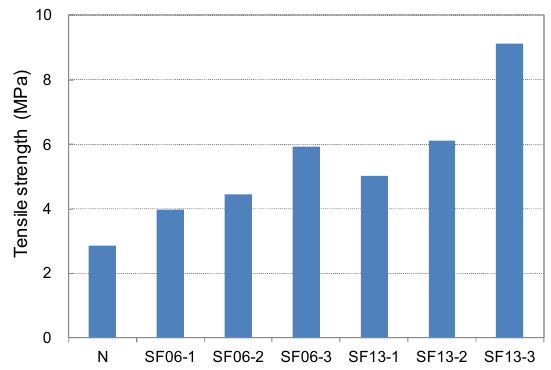
Figure 13. Compressive strength of steel fiber mortar.